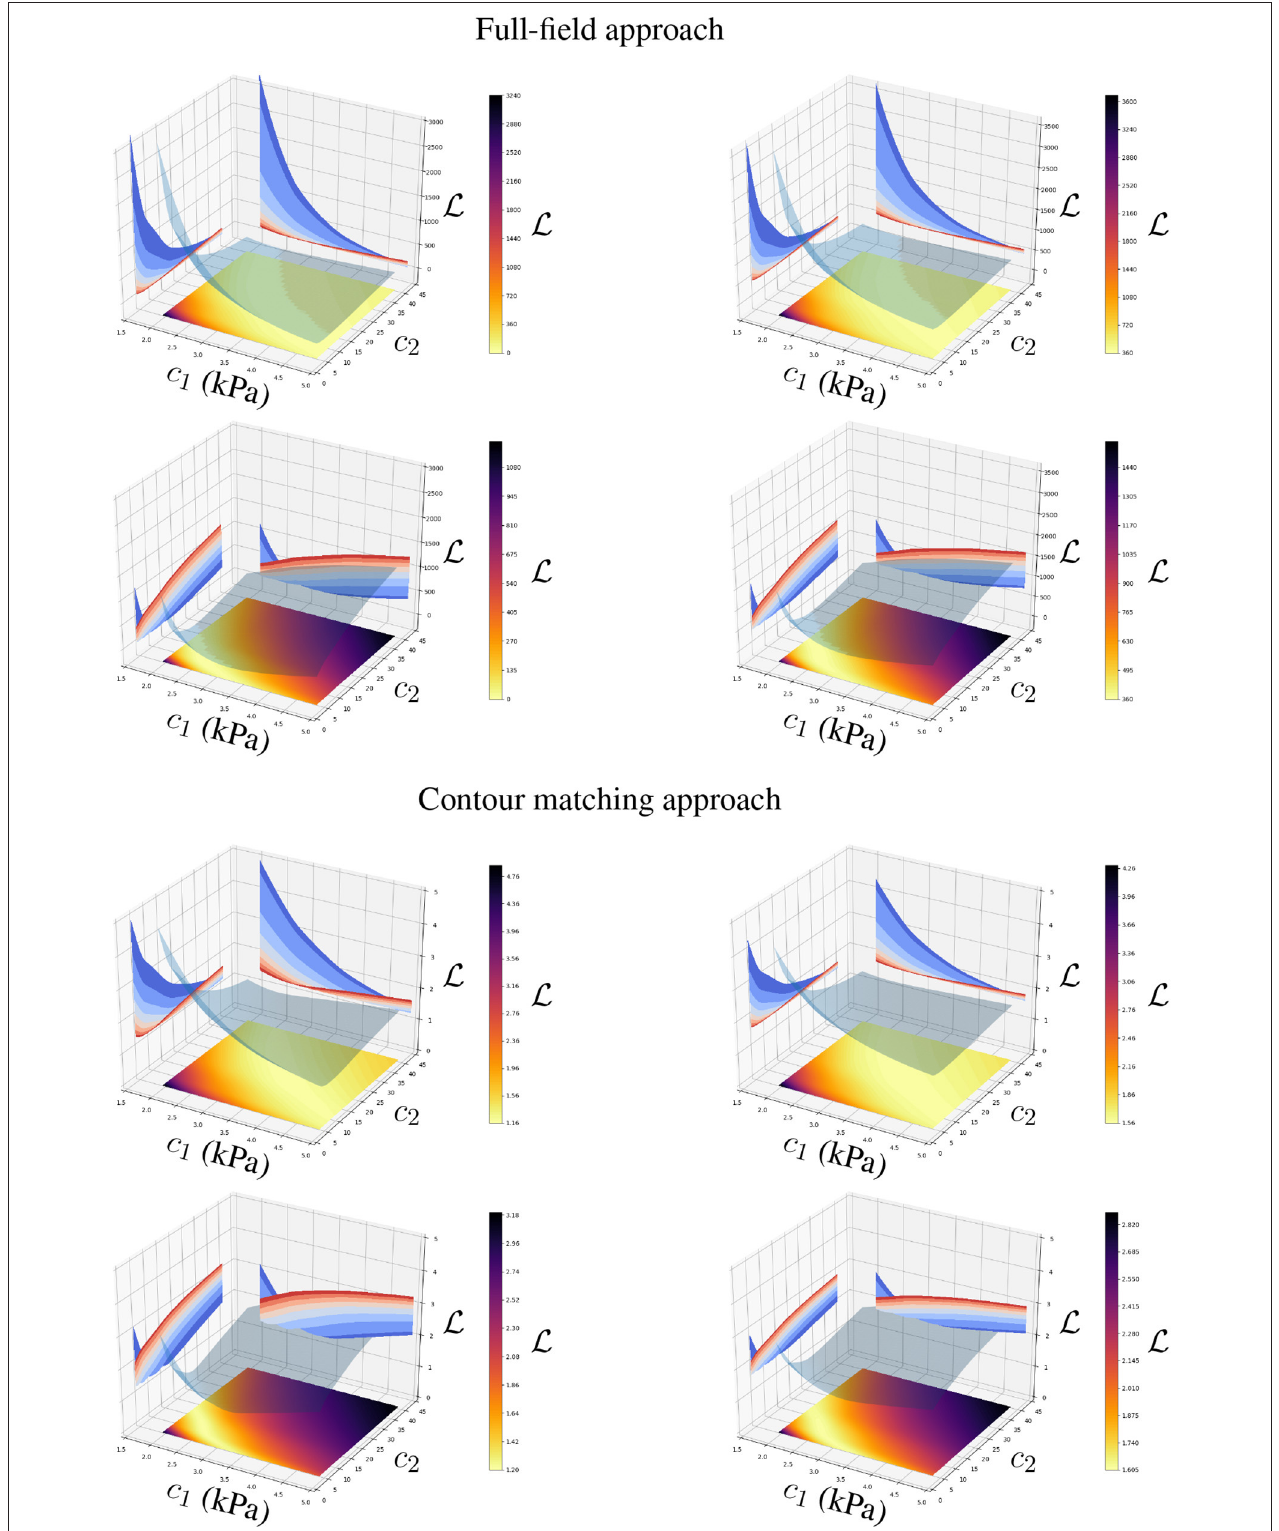
FIGURE 9 | Loss function for the full-field tracking and contour matching approaches with respect to c 1 and c 2 in the presence (right) and absence (left) of noise in the observations. The first and second rows present the loss function values when c 1 = 3.5 kPa, c 2 = 22.0 and c 1 = 2.5 kPa, c 2 = 10.0 are the ground